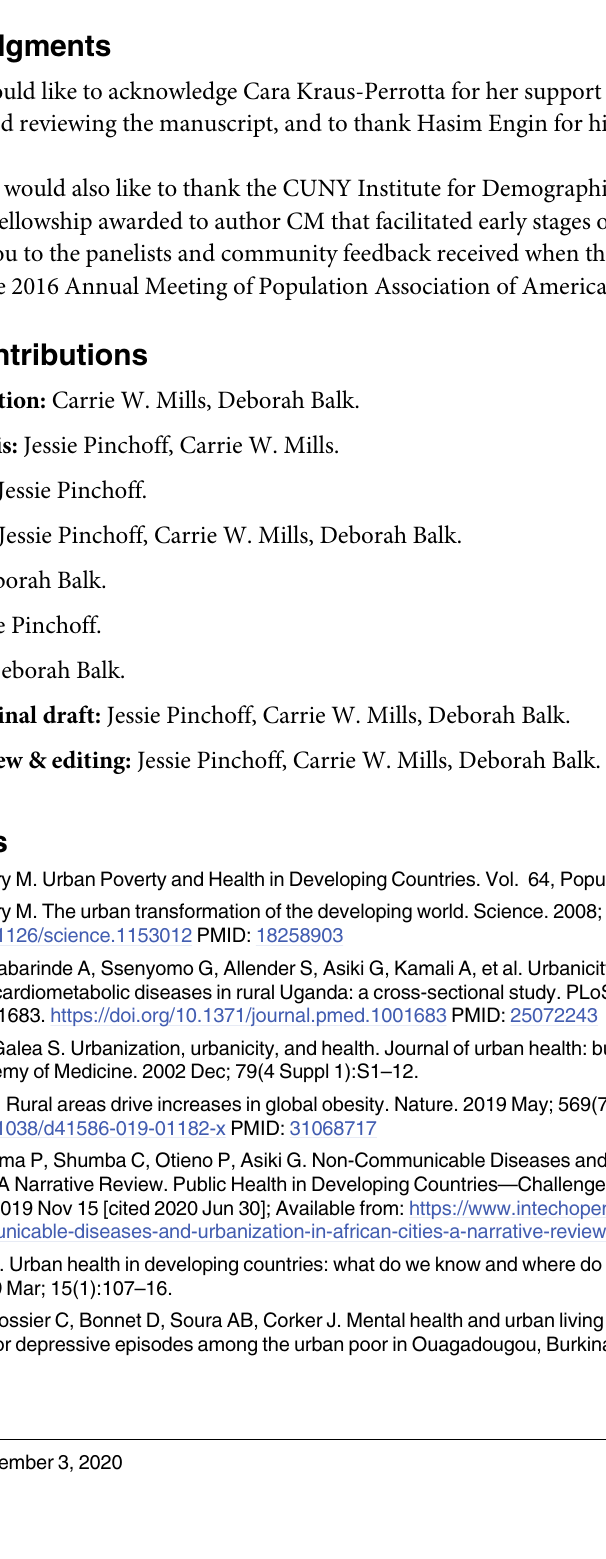
S1 Fig. Degree of urbanicity across wealth categories, by urban/rural